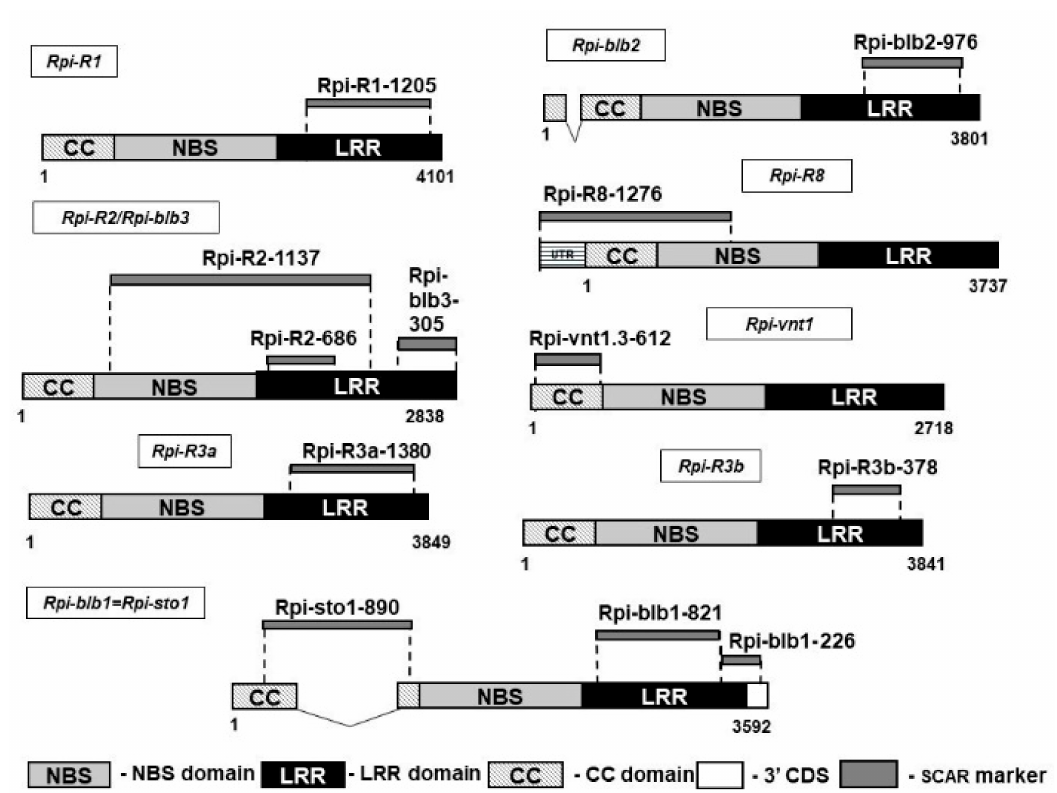
Figure 1. SCAR markers for the Rpi genes. The marker positions at the gene sequences are shown as regards the respective domains of CC-NBS-LRR kinases. For further details see Table